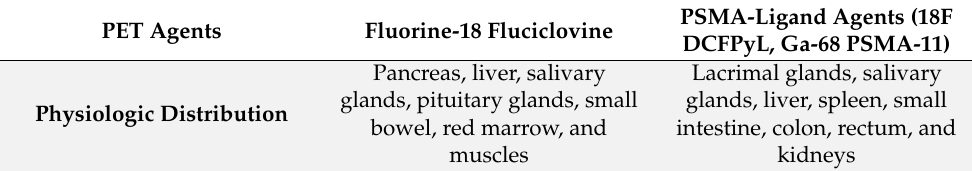
Figure 13. 18F DCFPyL MIP image shows normal physiologic uptake within the salivary glands, kidneys and collecting systems, liver, spleen, and bladder. Note the urinary contamination (arrow). For a summary of the physiologic distributions of the PET agents, please see Table 2. Table 2. Physiologic distribution of PET agents.